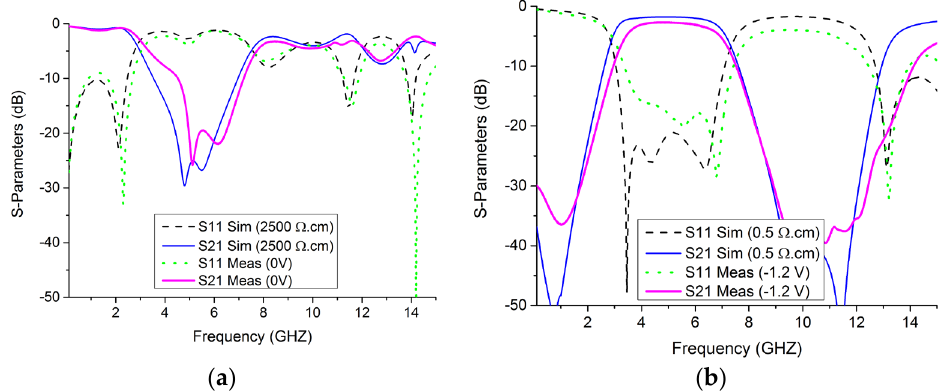
Figure 14. Comparison of the simulated and the measured results: ( a ) in the OFF-state; ( b ) in the ON-state.